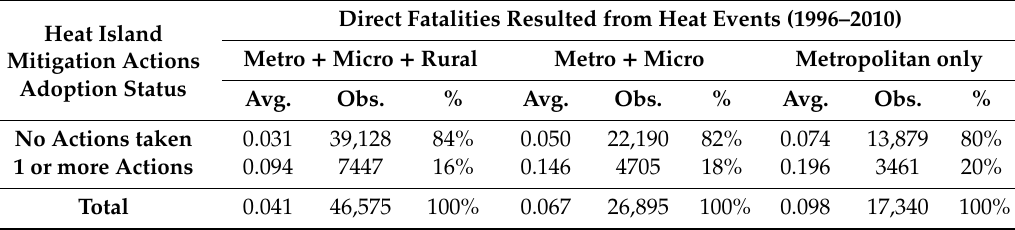
Table 3. Heat vulnerability and heat island mitigation (HIM) actions by metropolitan